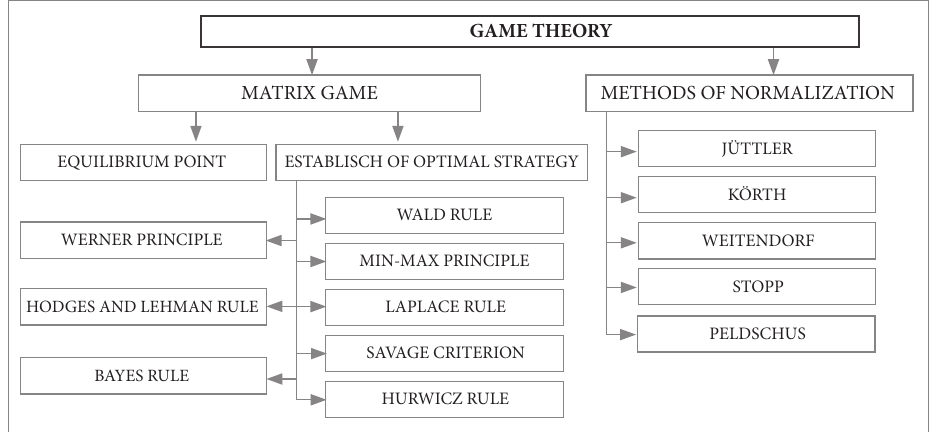
Fig. 1. Game theory classification by Zavadskas et al.